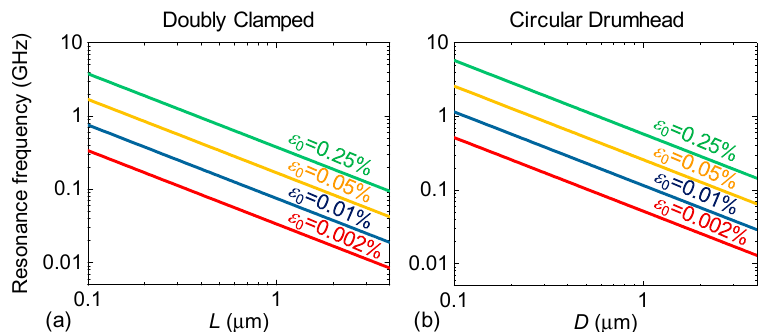
Figure 2. Calculated resonance frequencies of single-layer (1L) graphene resonators without applying gate voltage. Due to photoresist residue in fabrication and surface absorption, we assume the mass is higher than the intrinsic device mass (of carbon atoms only), and we take an effective mass ratio of 2 as the typical value. Frequency scaling of ( a ) doubly clamped membranes and ( b ) circular drumhead graphene resonators. The labels represent built-in strain levels in the devices.